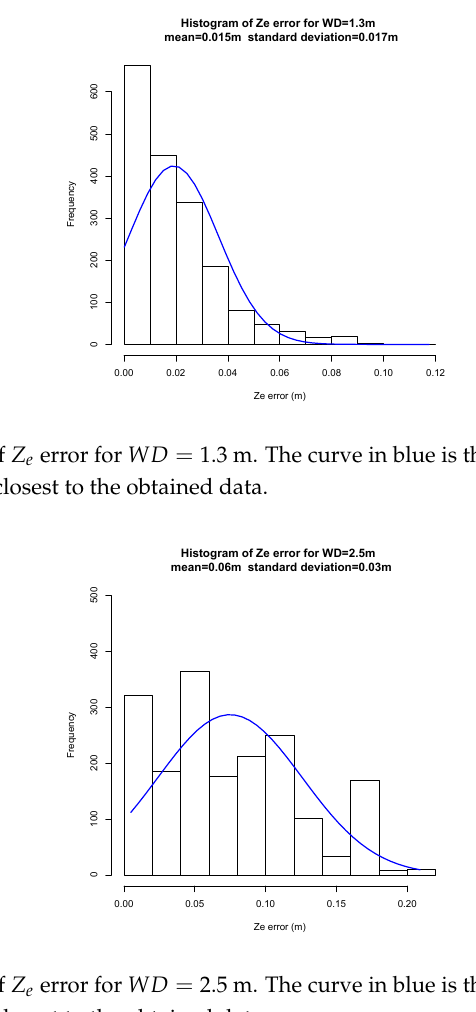
Figure 24. Histogram of Z e error for WD = 0.5 m. The curve in blue is the curve estimated by R as the Gaussian curve that is closest to the obtained data.